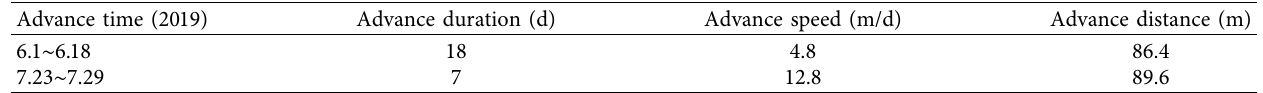
Table 2: Comparison of rate of advance of working face in different